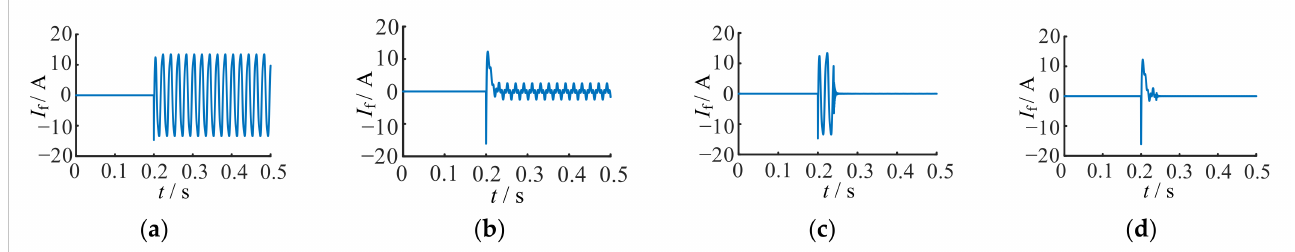
Figure 5. Fault-current simulation results under different grounding modes. ( a ) Ungrounded mode; ( b ) grounding through the arc-suppression coil mode; ( c ) dual-frequency active arc-suppression mode; ( d ) hybrid flexible grounding